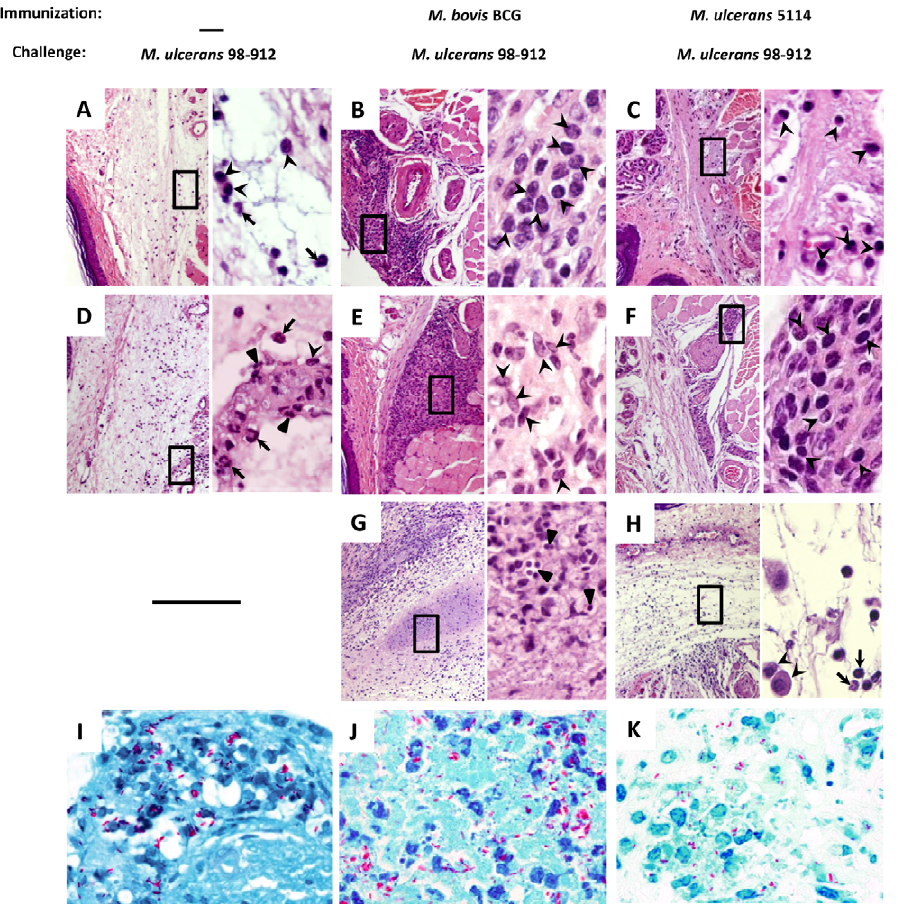
Figure 6. Immunization induces a transient mononuclear inflammatory response in the footpad of M.ulcerans challenged mice. Mice were either non-immunized (A, D, and I) or immunized with BCG (B, E, G, and J) or with mycolactone-negative M. ulcerans 5114 (C, F, H, K) two months before challenge. All mice were infected in the footpad with 2 log 10 CFU of M. ulcerans 98–912. The footpads were harvested at on day 60 (A–C), day 70 (D–F and I), or day 150–200 (G–H and J–K) and processed for histology. Tissue sections were stained with HE (A–H) or ZN (I–K). (A, D, and I) Non- immunized mice showed a persistent mixed inflammatory infiltrate composed of mononuclear cells (arrowheads) and neutrophils (arrows). Necrotic areas harbored abundant extracellular bacilli (I) and cells with apoptotic morphology (triangles). (B, C, E, F, G, H, J, and K) The footpads of vaccinated mice presented a mononuclear inflammatory infiltrate (arrowheads) throughout the initial weeks of experimental infection, which was later replaced by a predominantly neutrophilic infiltrate (arrows) and/or apoptosis (triangles) and extracellular bacilli (J, K). Images are representative of 4 footpads per group. Original magnification: 10 6 . Original magnification of HE inserts: 100 6 . Original magnification of ZN: 100 6 .